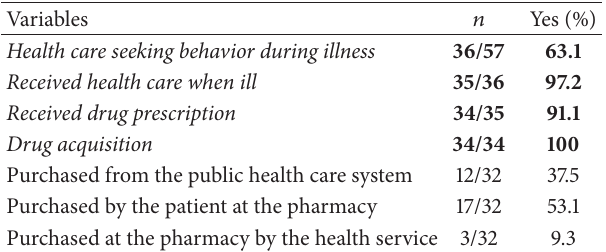
Table 5: Search and access to health services for children under 5 years who with presented morbidities in the last 15 days, I˜napari, 2011.